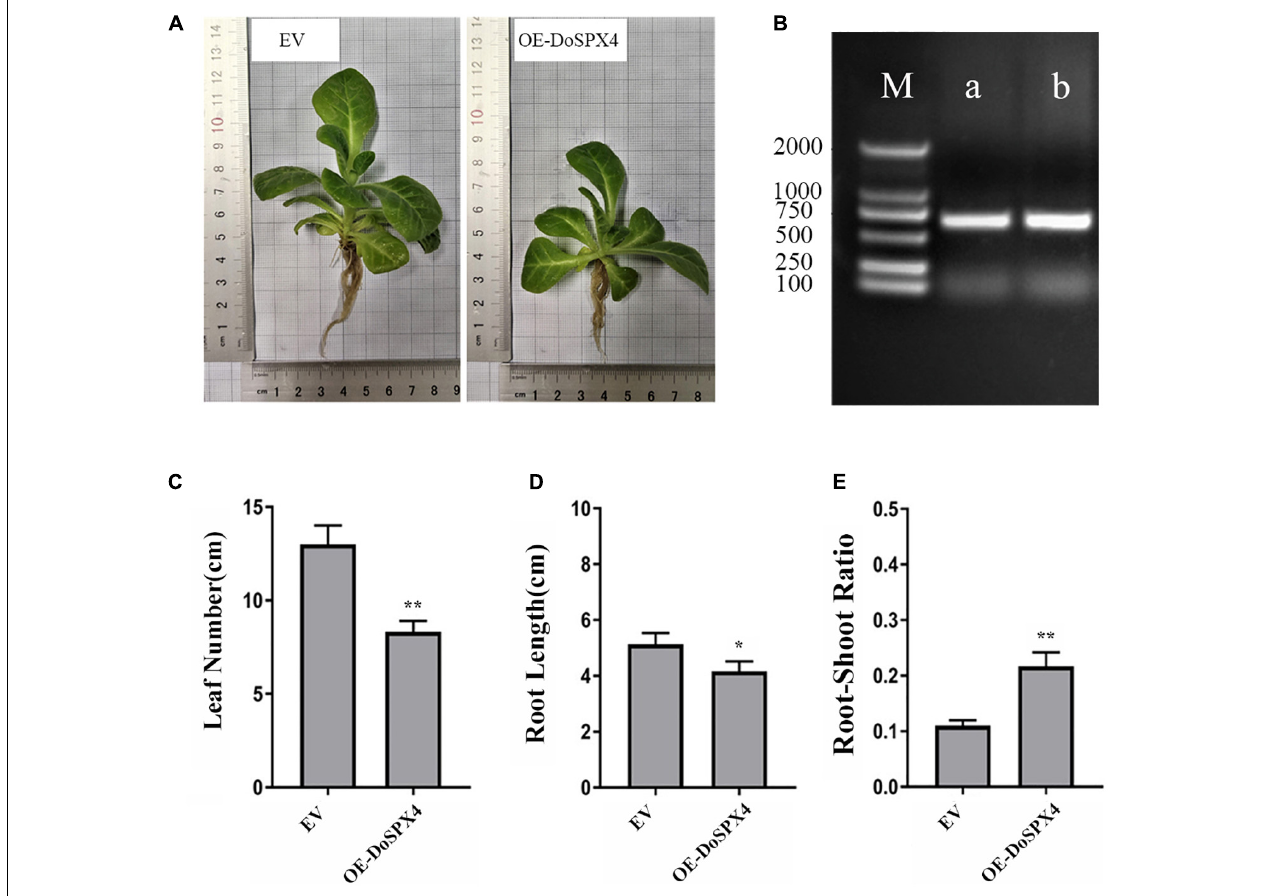
FIGURE 7 | Transgene analysis. (A) Phenotypic difference of OE- DoSPX4 transgenic N. tabacum . (B) Identification of positive transgenic N. tabacum lines by PCR (M represent DL2000 DNA marker, a represent EMPTY VECTOR, b represent OE- DoSPX4 ). (C) The leaf number of OE- DoSPX4 transgenic N. tabacum. (D) The root length of OE- DoSPX4 transgenic N. tabacum. (E) The root–shoot ratio of OE- DoSPX4 transgenic N. tabacum. Each sample included at least three replicates, and the values are the means ± SDs . *Indicates that the difference is significant, **Indicates that the difference is very